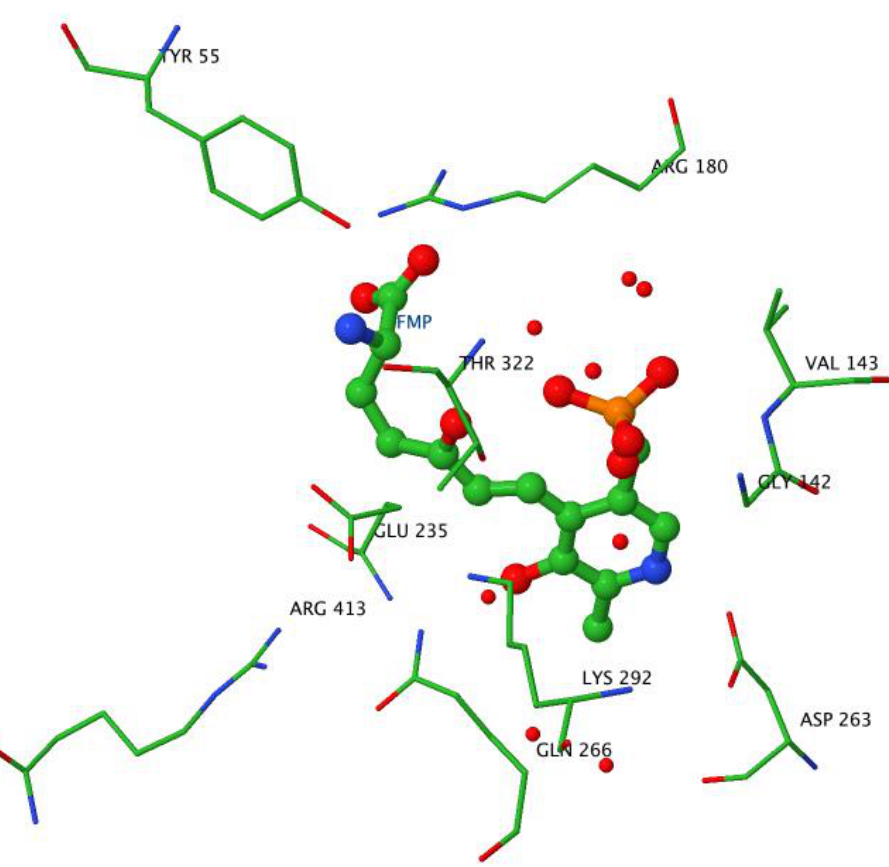
Figure 7. Active site geometry. Image created with JMol using the OAT-5FMOrn crystal structure coordinates. The ball and stick structure shows the adduct formed by the reaction of 5FMOrn with PLP. The wireframe structures indicate the residues stabilizing the adduct in the active site in particular Y55, R180, K292, and the shielding of R413 by E235.